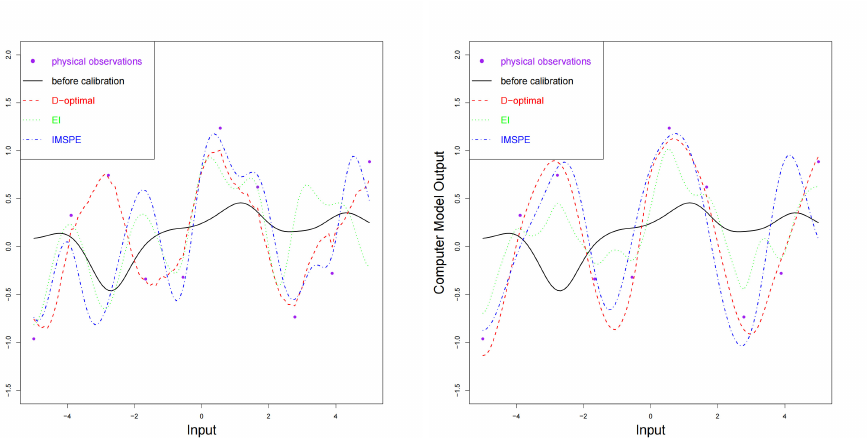
Figure 3. Model outputs before and after calibration through the proposed sequential D-optimal method, EI method, and IMSPE method, compared with the physical observations. The left and right panels show the results obtained by sequentially adding 14 and 30 points, respectively.